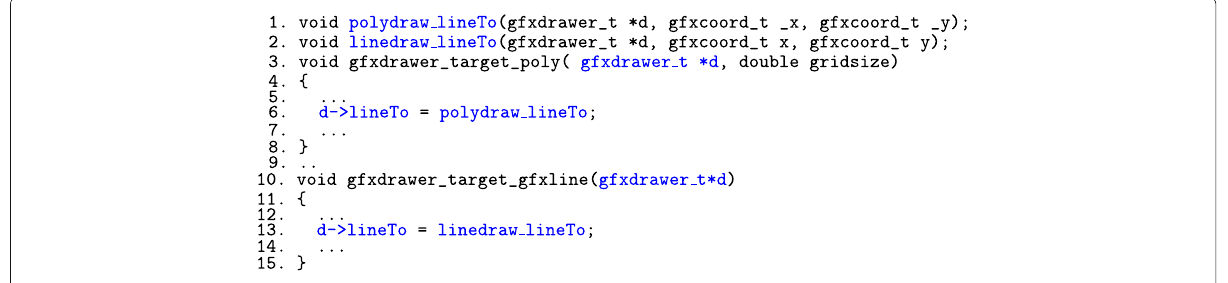
Fig. 4 E.g. definitions of function pointer in a struct field